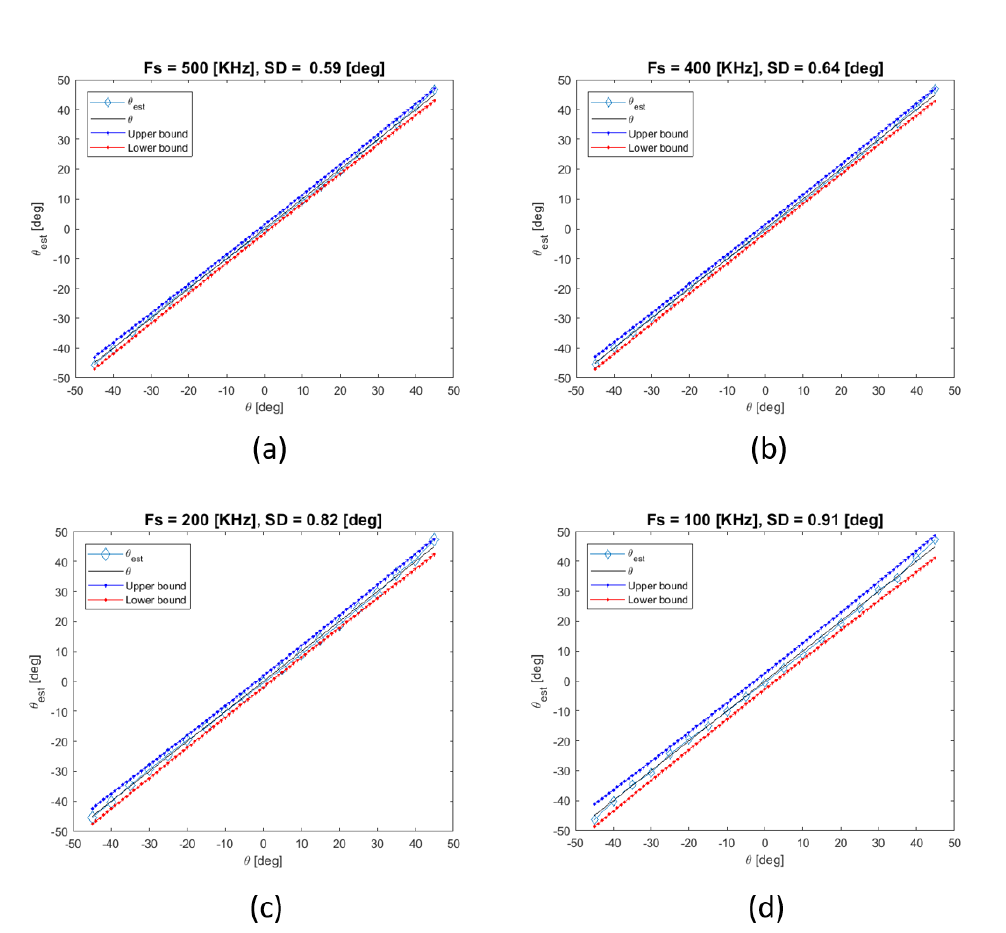
Figure 7. Estimated DoA ( θ est ) with respect to the actual DoA ( θ ) at different sampling frequency values (indicated in the title of subplots, with the computed value of standard deviation of DoA) for the case of A 0 mode propagating (the upper and lower bound limits computed according to the Propagation of Uncertainty theory on the basis of the ideal sensors